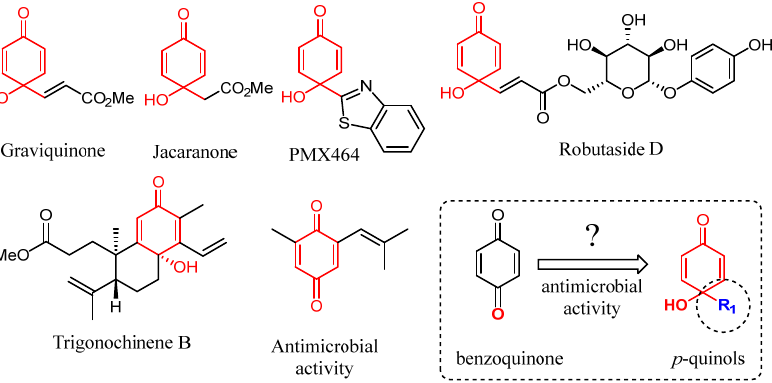
Figure 1. Biologically active 4-substituted 4-hydroxycyclohexa-2,5-dienones class ( p -quinols).